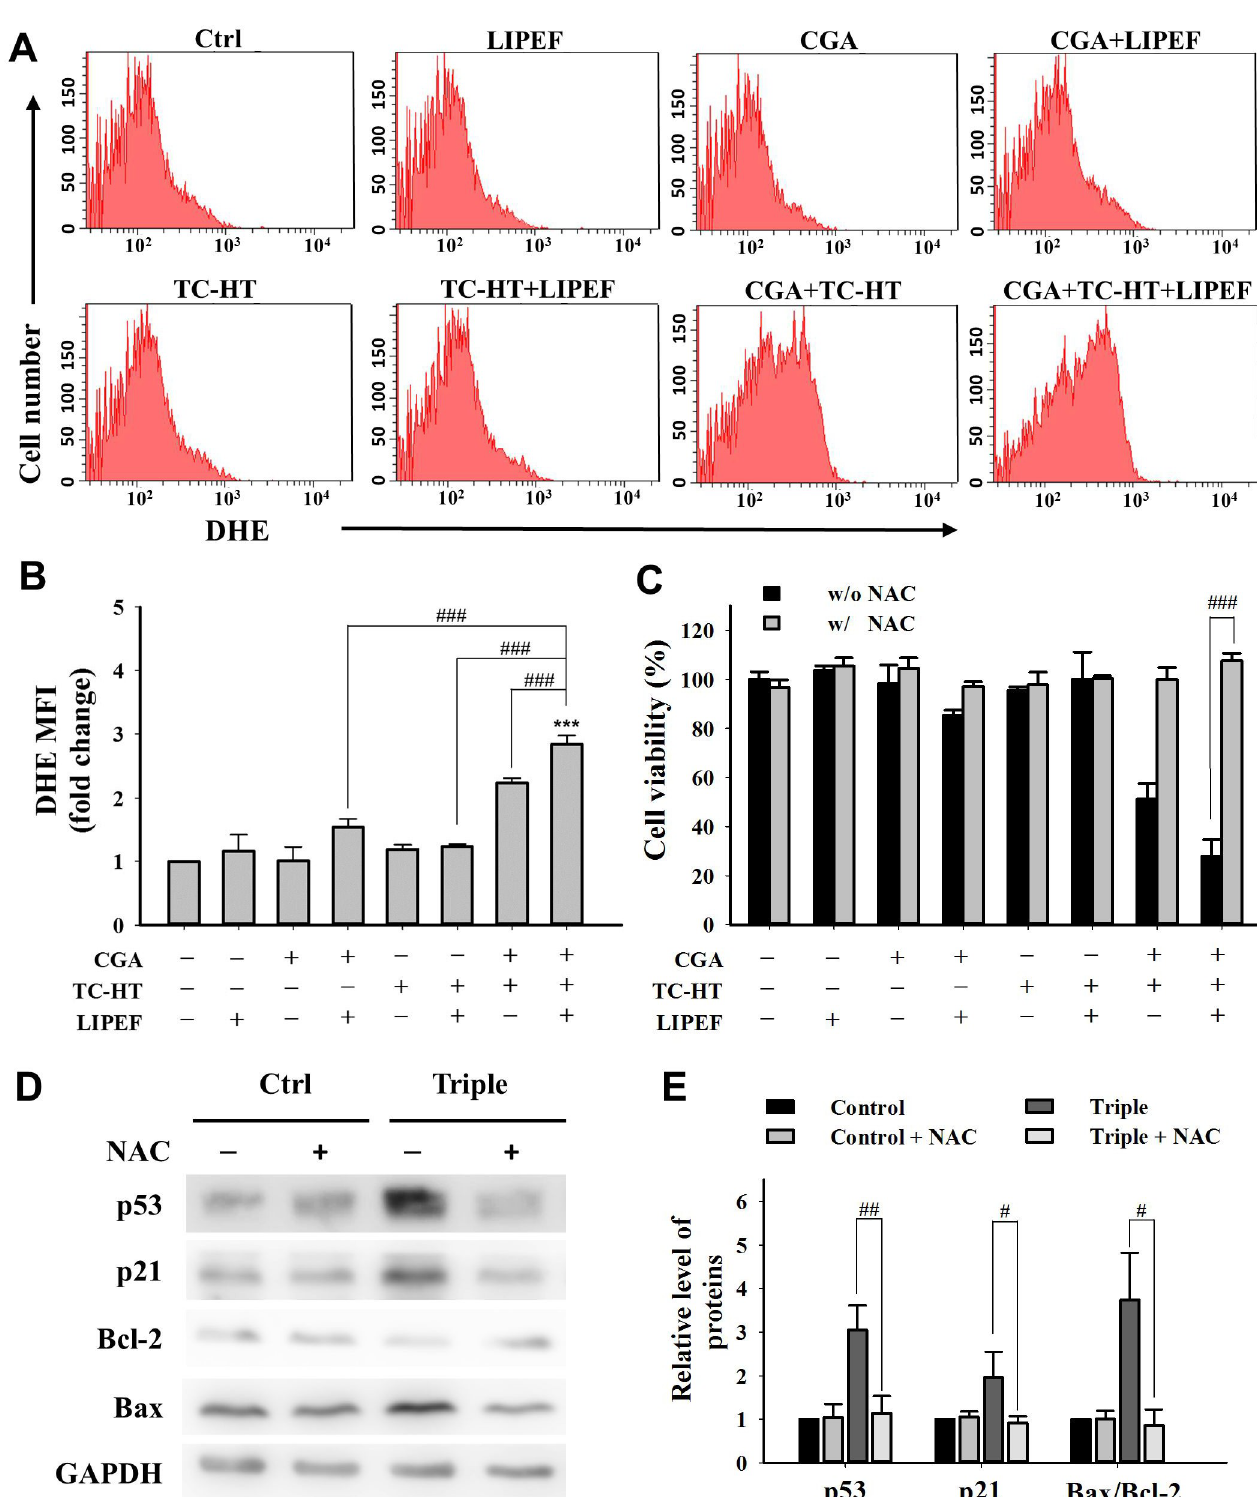
Fig 7. Combined effects of CGA, TC-HT, and LIPEF on ROS generation in PANC-1 cells. (A) The DHE (O 2• − ) levels were measured by flow cytometry after treatment with CGA (200 μ M), TC-HT (10-cycles), and LIPEF (60 V/cm) alone, in double or triple combination on PANC-1 cells for 24 h. (B) Graph shows the fold change in MFI of DHE relative to control. (C) The PANC-1 cells were treated with the same parameters of CGA, TC-HT, and LIPEF alone or in